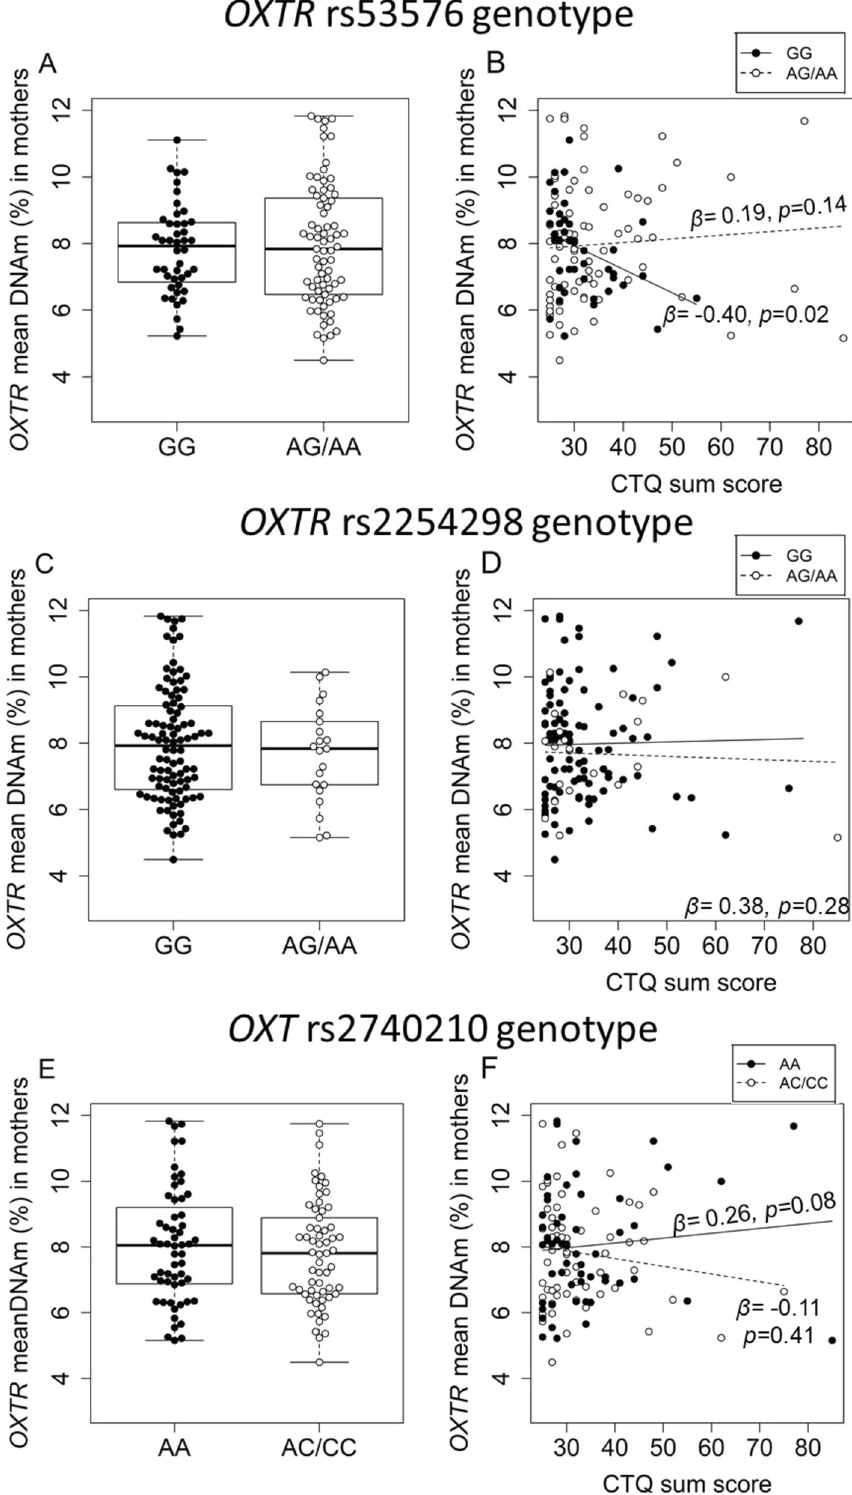
mean OXTR DNAm levels (Girls: CM − dyads: n = 24, β = 0.45, p = 0.02; CM + dyads: n = 28, β = 0.08, p = 0.76/Boys: CM − dyads: n = 33, β = 0.71, p < 0.001; CM + dyads: n = 27, β = 0.10, p =